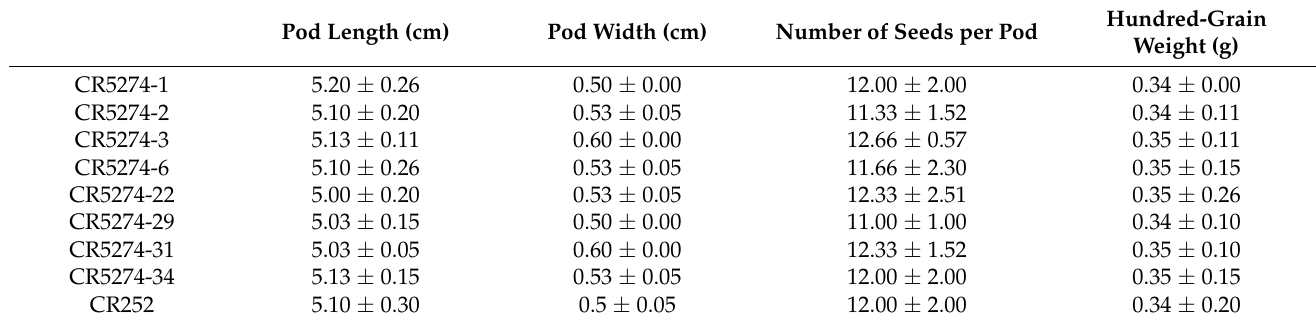
Table 7. Differences in main, botanical characters of offspring and recurrent